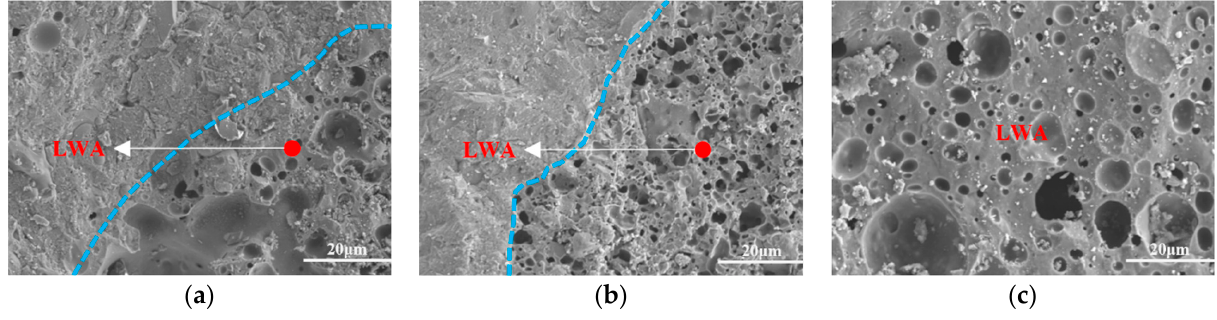
Figure 11. SEM images of LWA with different particle sizes: ( a ) 0.15–4.75 mm; ( b ) 0.15–2.36 mm; ( c ) 0.15–1.18 mm.